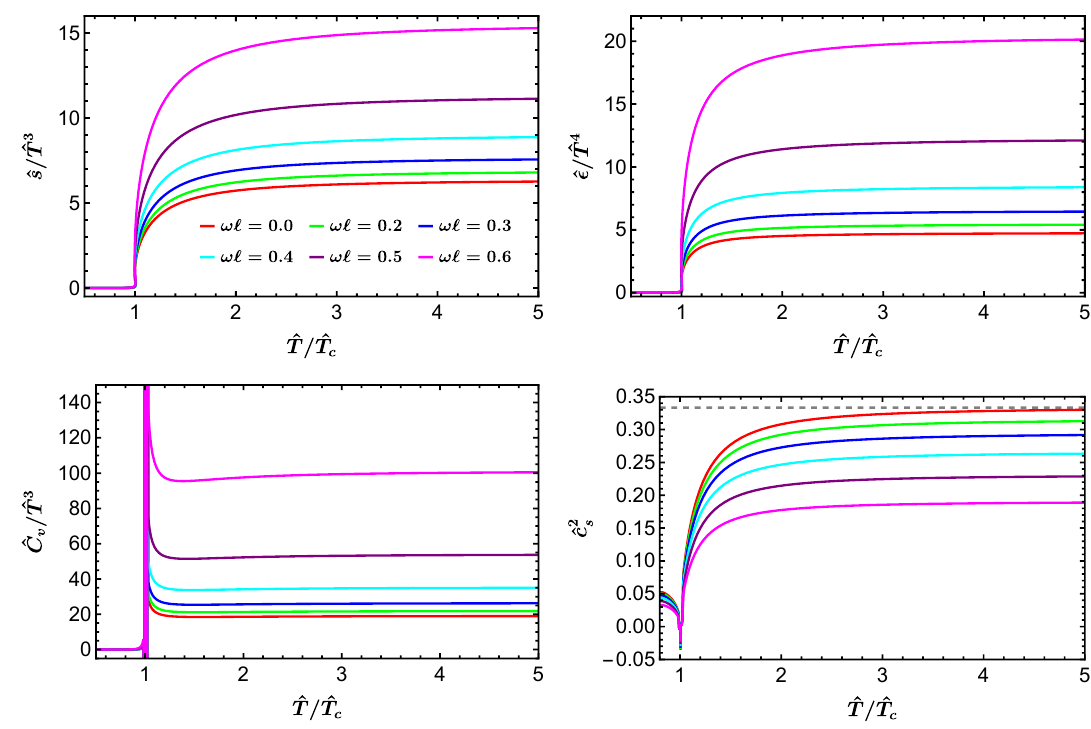
Figure 10 . Various thermodynamic quantities in function of normalized temperature ˆ T/ ˆ T c of the pure gluon system at different angular velocities. With the increase of ω , ˆ s/ ˆ T 3 , ˆ (cid:15)/ ˆ T 4 and ˆ C v / ˆ T 3 are enhanced, while ˆ c 2 is suppressed. s